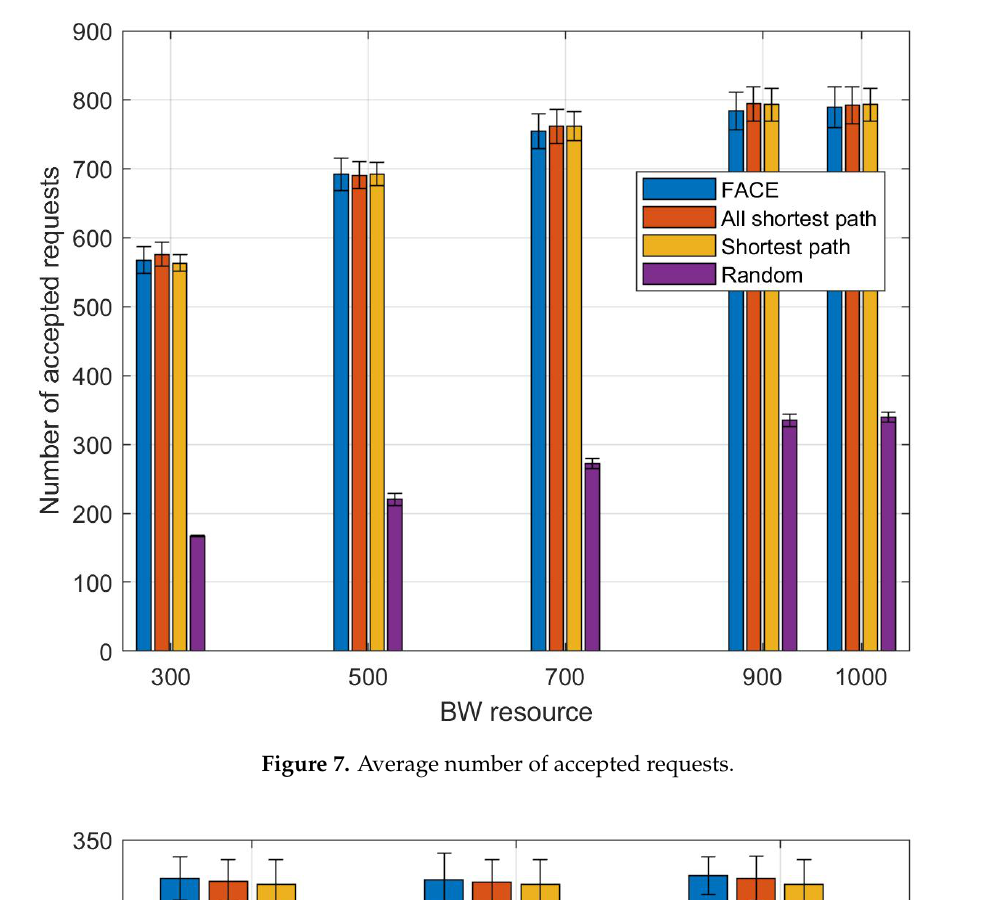
Figure 7. Average number of accepted requests.